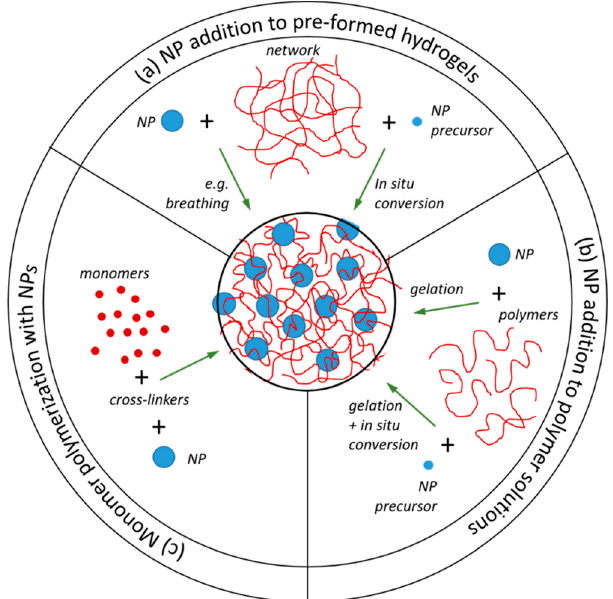
Figure 2. Approaches used for preparing nanoparticle—hydrogel composites: ( a ) NP addition to pre-formed hydrogels; ( b ) NP addition to polymer solutions and ( c ) Monomer polymerization in the presence of NPs. See text for details.